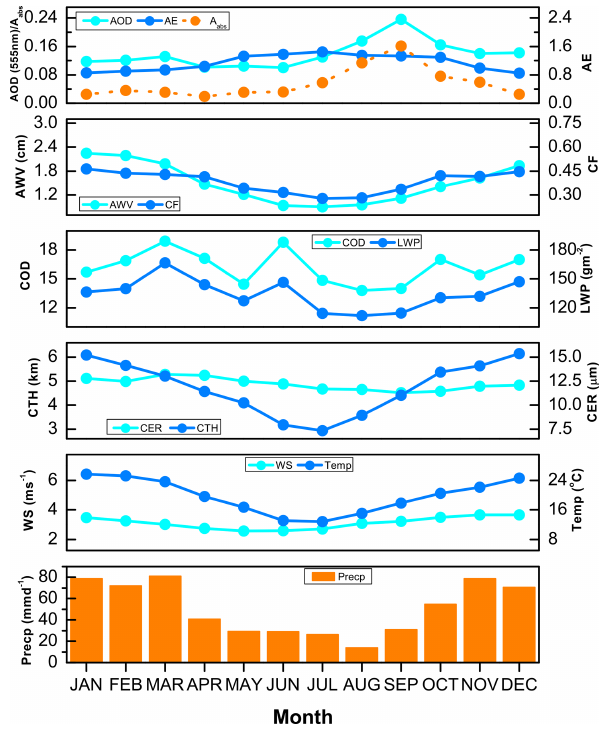
Figure 11. Intercomparison of average monthly variation of aerosol (AOD, AE, A abs ), AWV, cloud (CF, LWP, COD, CTH, CER), and meteorology (WS, TEMP, PRECP) parameters over upper South Africa.